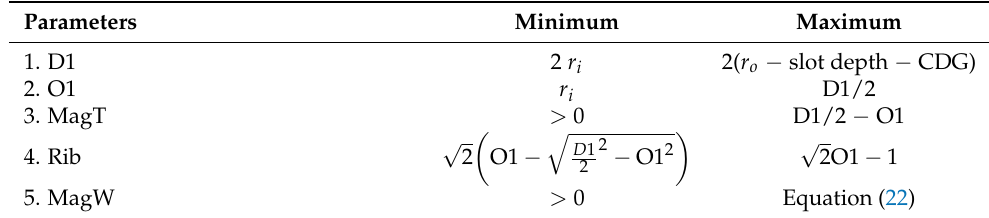
Table 7. Restrictions for magnet dimensional parameters.